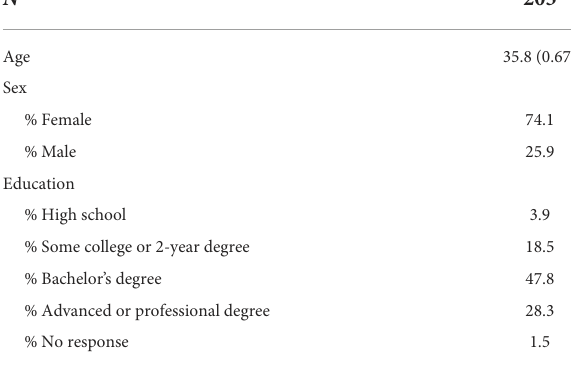
TABLE 1 Participant demographics: Age presented as Mean